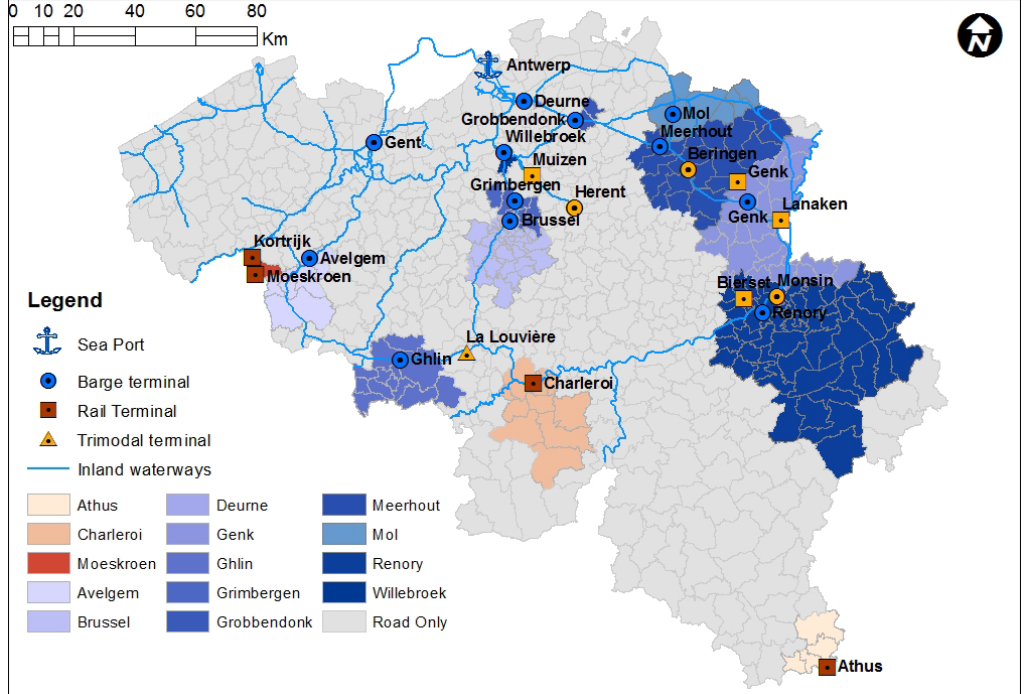
Figure 2. LAMBIT reference output, depicting the market areas of existing intermodal terminals for transport to/from Antwerp. The terminals depicted in orange do not have regular services to/from